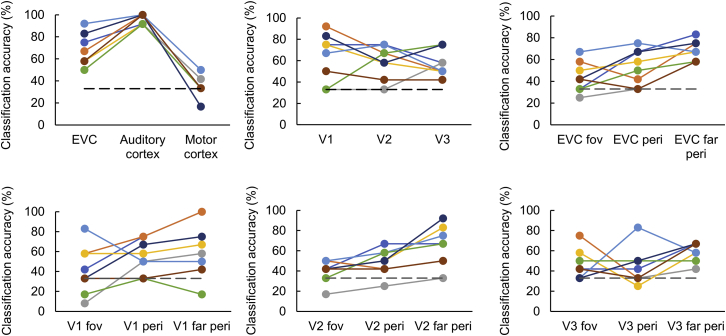
Classification Results for Individual Blind ParticipantsChance level (one out of three) is marked with dashed lines. EVC, early visual cortex (areas V1, V2, and V3 combined). See also Table S1.